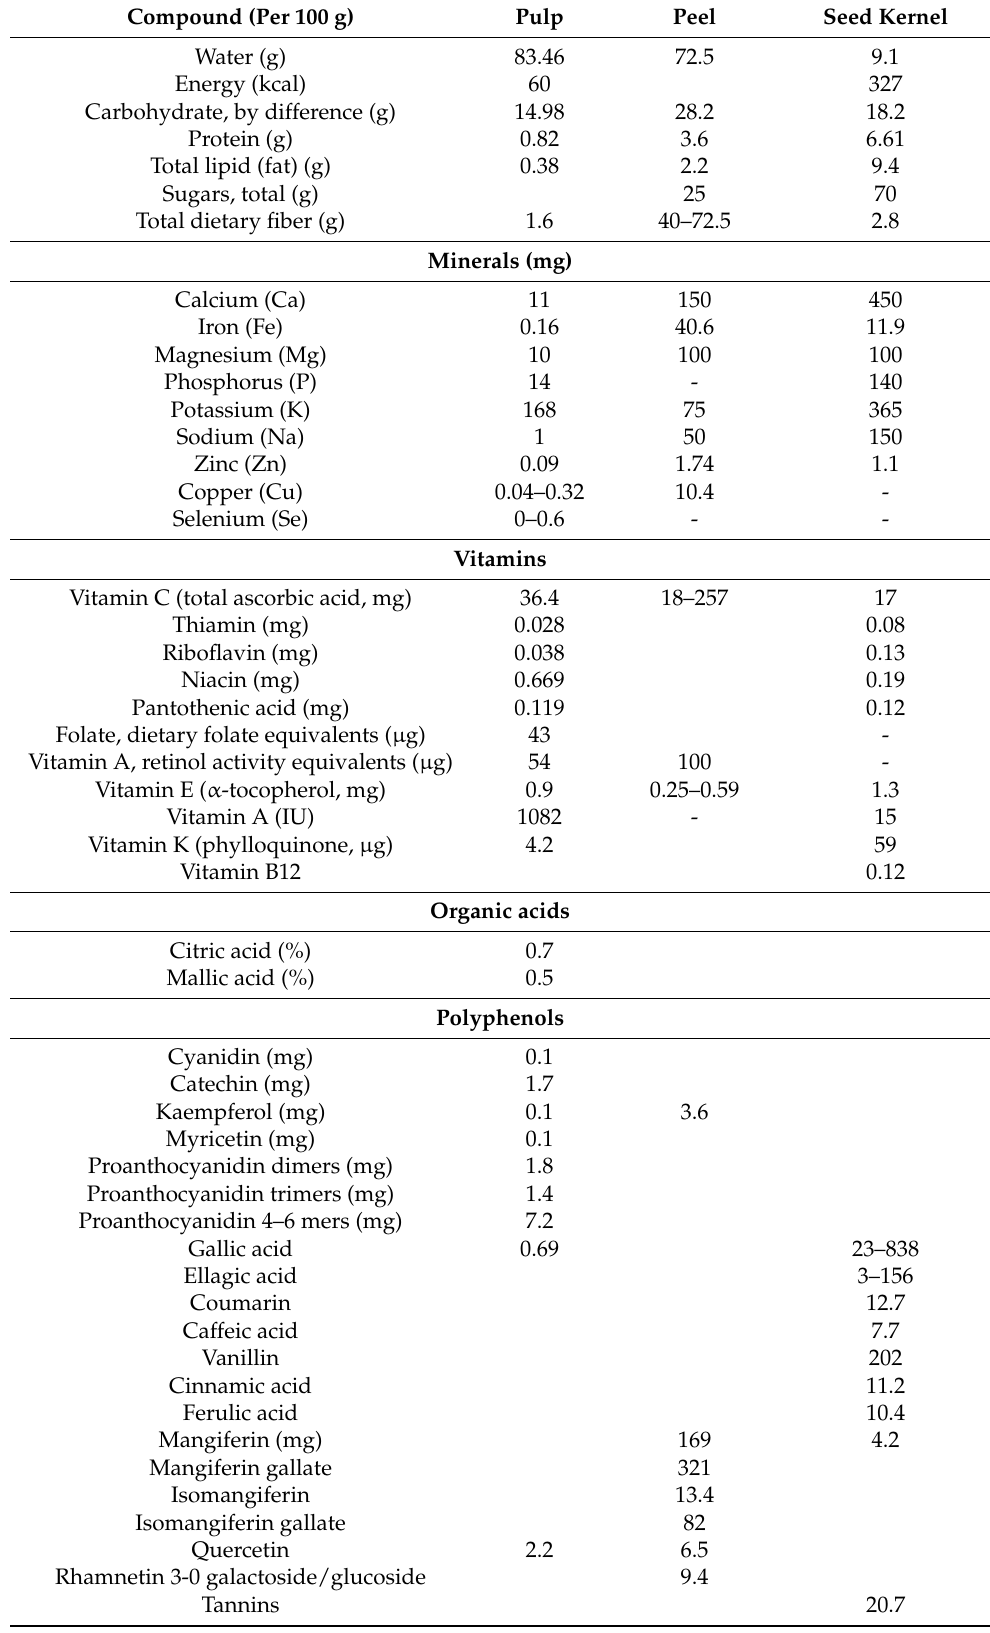
Table 1. Nutritional and functional phytochemical composition of mango pulp, peel, and seed